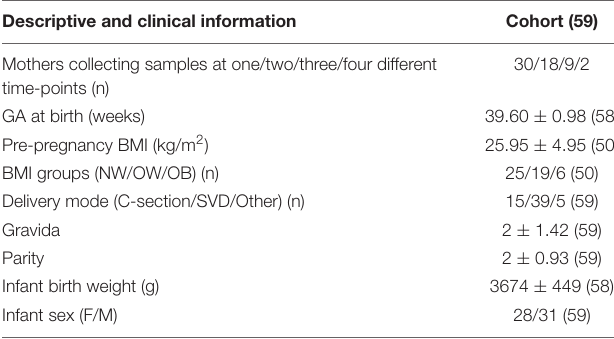
TABLE 1 | Subject characteristics of cohort with continuous data presented as means, ± standard deviation and number of observations in round brackets. Descriptive and clinical